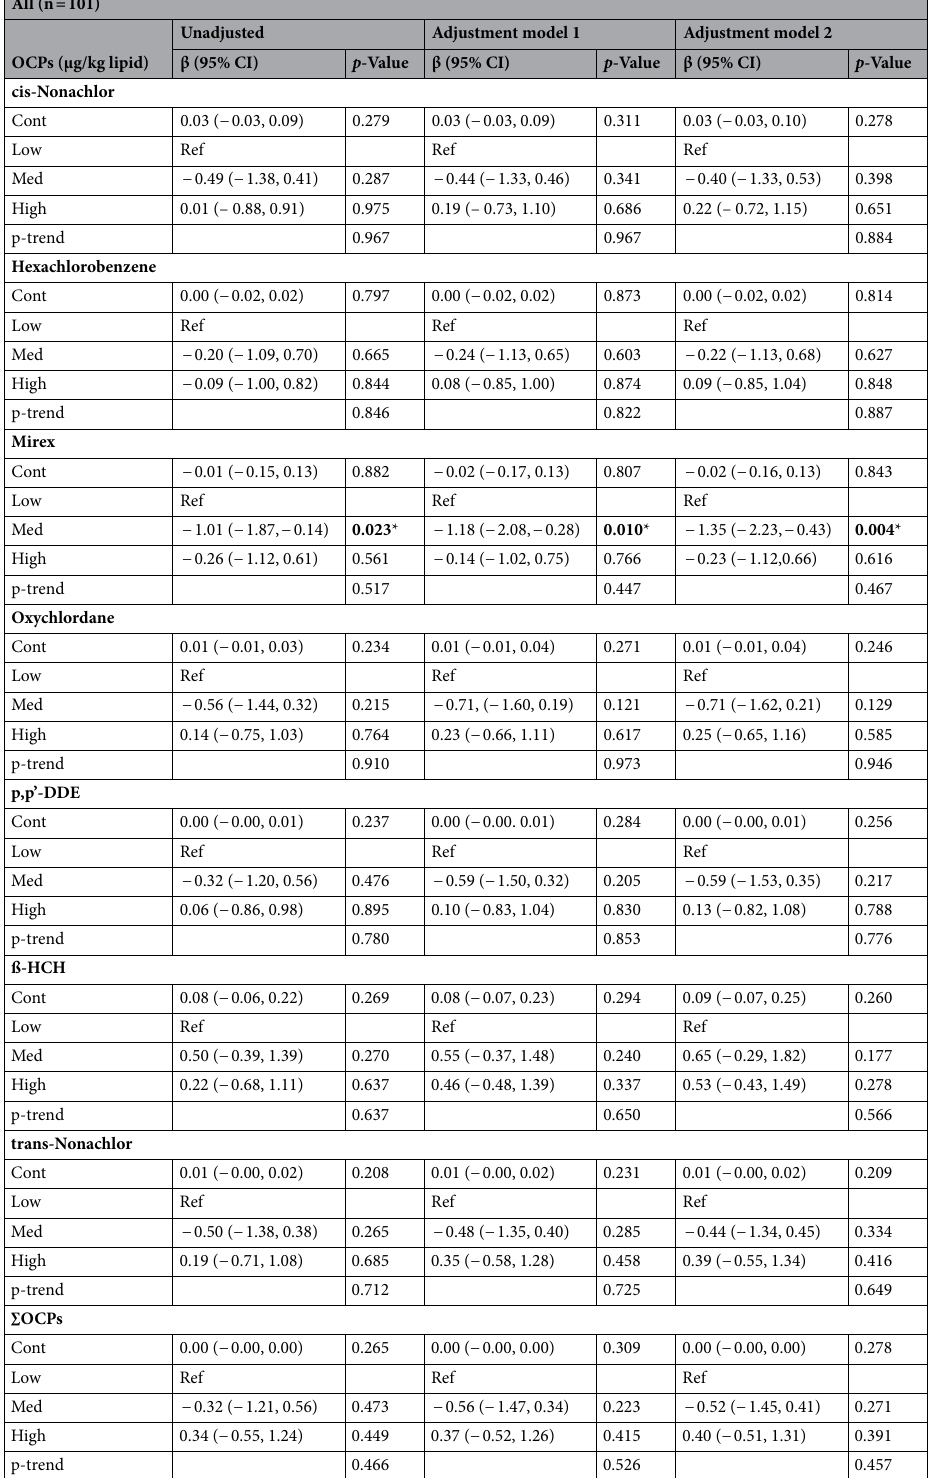
Table 5. Linear regression analysis of the associations between prenatal OCP exposure and continuous hyperactivity score: Greenlandic children 3–5 years of age born 2014–2016, the ACCEPT birth cohort. n Number of participants in parameter, β Linear regression coefficient in score points, CI confidence interval, Bold text and *= Significant ( p ≤ 0.050), Bold text and ** = Borderline significant ( p ≤ 0.100), Adjustment model 1: Maternal plasma cotinine, maternal educational level, maternal age at delivery, Adjustment model 2: Adjustment model 1 + breast-feeding duration, Med = Medium, Cont. = Continuous, OCPs organochlorine